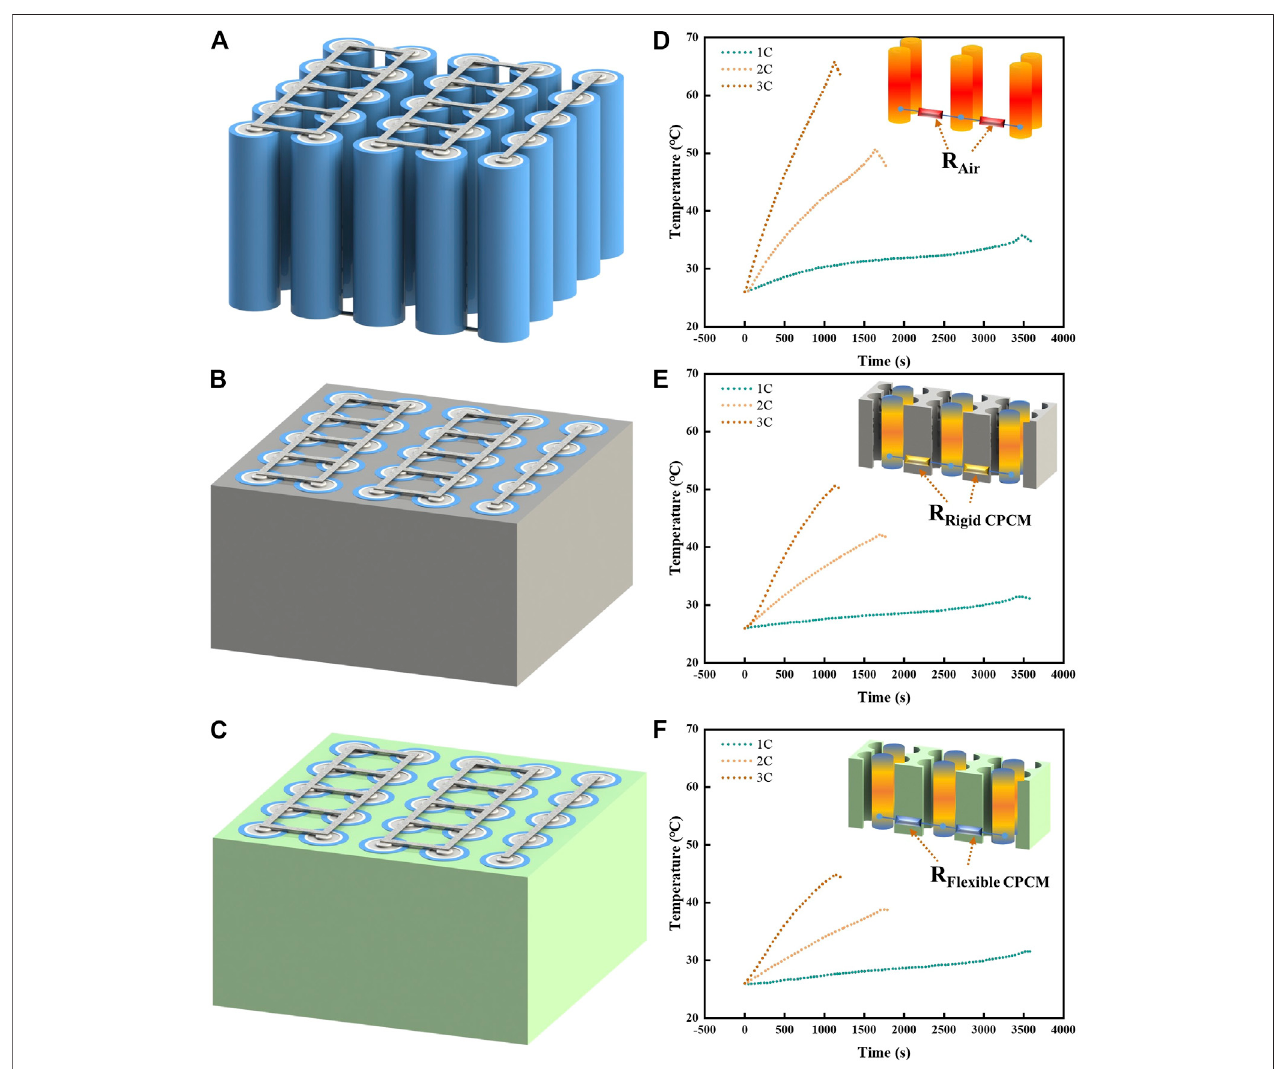
FIGURE 7 | Three battery modules with various cooling systems: (A) Air cooling, (B) rigid CPCM, and (C) fl exible CPCM. Temperature curves of the three battery modules with different cooling systems: (D) Air cooling, (E) rigid CPCM, and (F) fl exible CPCM at 1C, 2C, and 3C discharge rates.